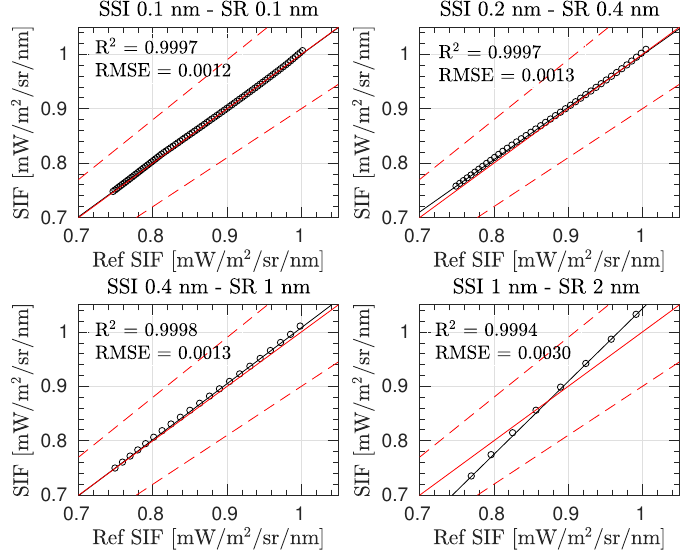
Figure 10. Scatter plots of the reference spectra and estimated SIF spectra values (black circles) in the interval between 759.0–767.5 nm, for different instrumental spectral resolutions (SR) and sampling interval (SSI). Estimated SIF was derived by applying the SFM at TOC surface level. Red solid line represents the 1:1 line, and red dashed lines define the region for a SIF relative error lower than